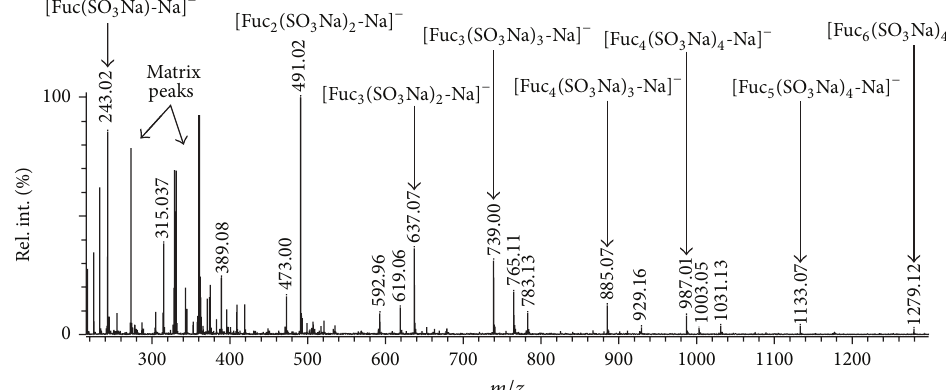
Figure 1: Negative-ion MALDI-TOFMS of Cf2-AH sample: product of “soft” autohydrolysis of Cf2 fucoidan fraction from the brown alga C. langsdorfii